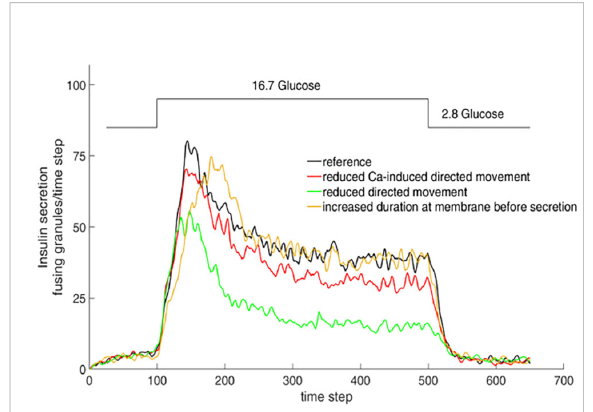
FIGURE 4 Simulation of insulin secretion as function of granule